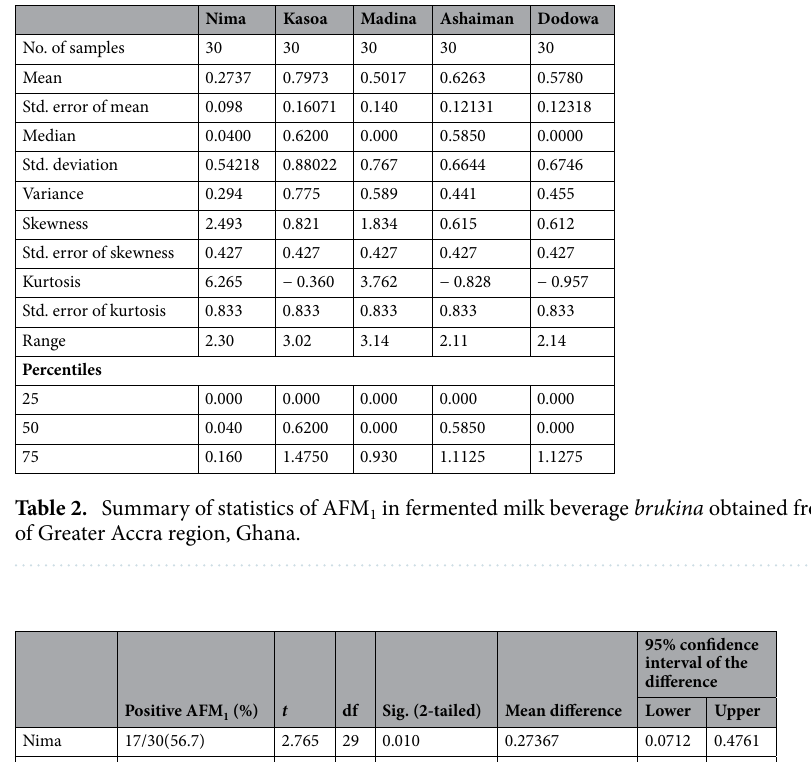
Positive AFM 1 (%) t df Sig. (2-tailed) Mean difference